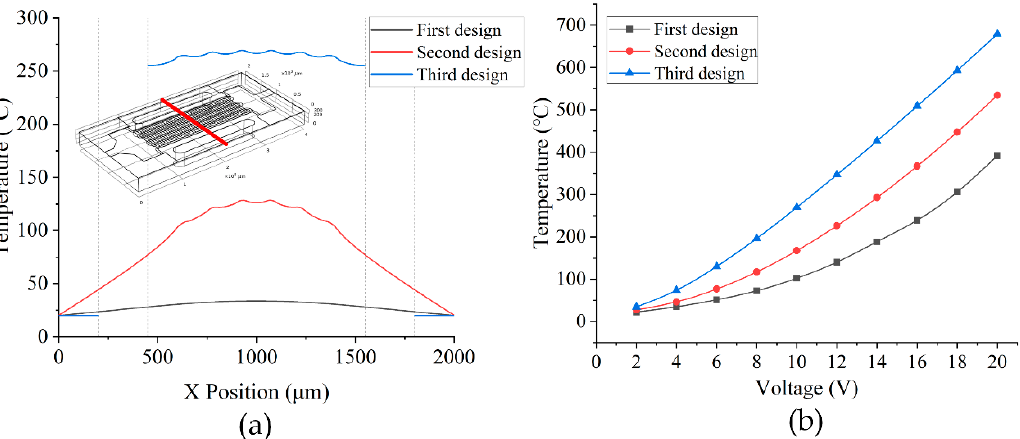
Figure 9. Simulation results for the three designs: ( a ) temperature distribution on the x-axis of the upper surface of the micro-hotplate at a voltage of 10 V and ( b ) variation in the maximum temperature on the upper surface of the micro-hotplate at voltages from 2 V to 20 V.